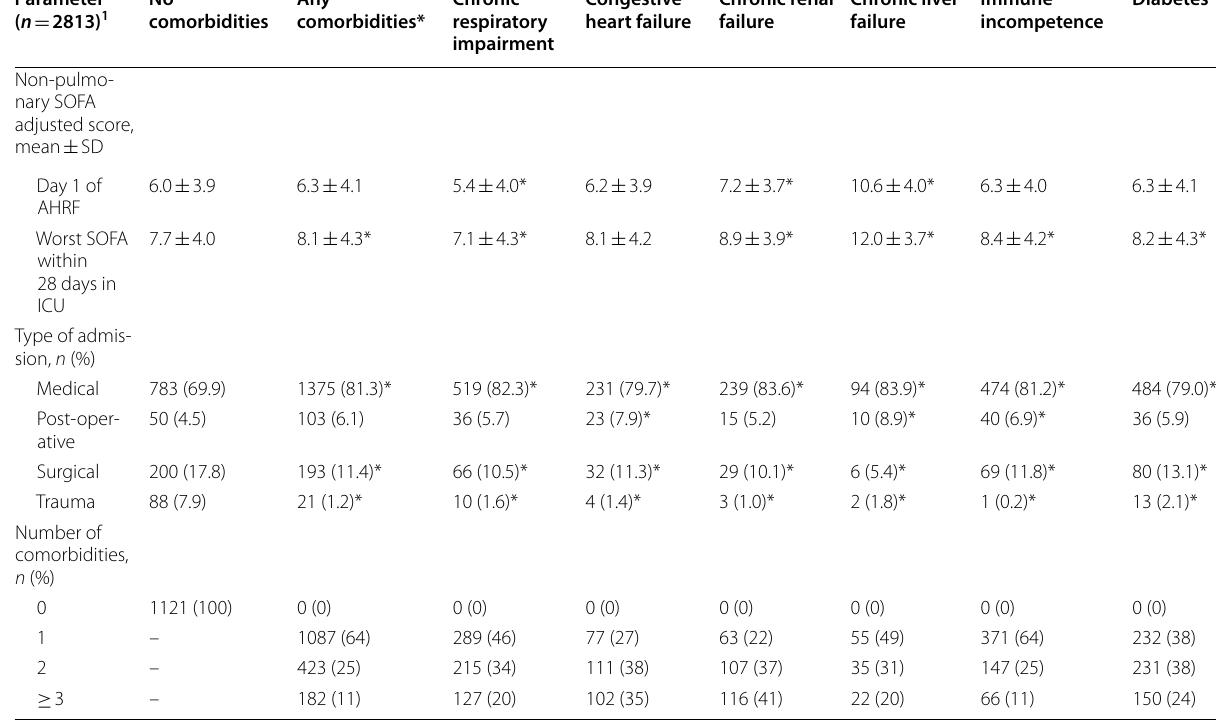
Table 2 Multivariate logistic regression model of factors associated with the use of any adjunctive measures within 28-day follow-up